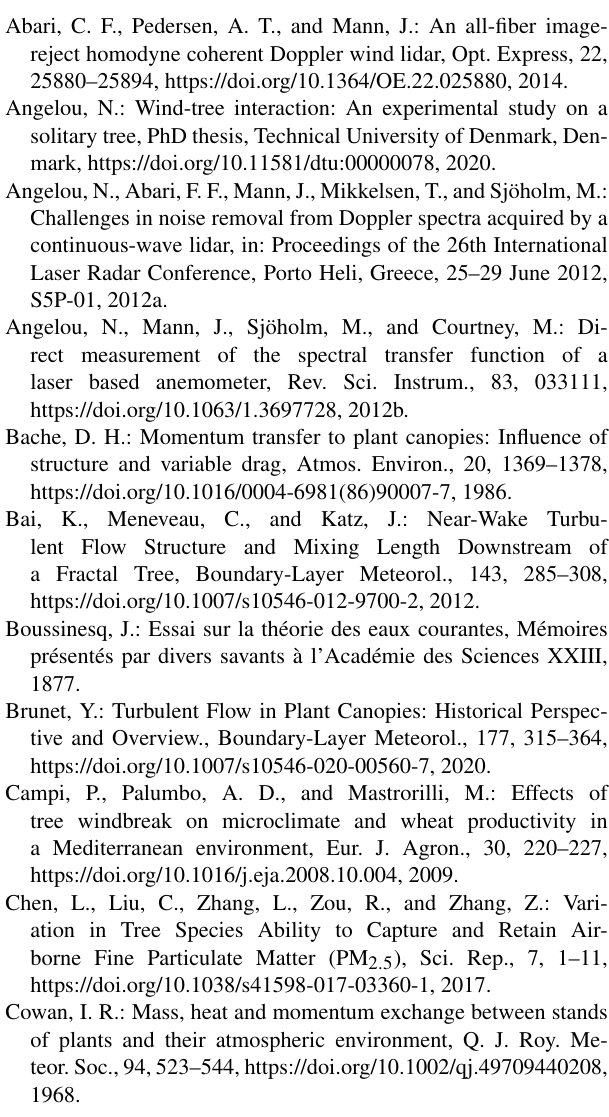
Data availability. The data used in this study are available upon